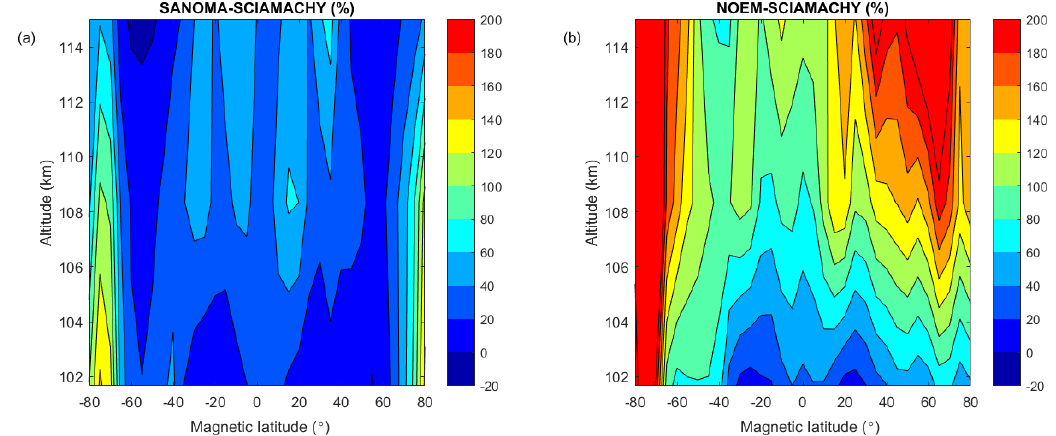
Figure 17. (a) Median difference between SANOMA and SCIAMACHY as a percentage of mean SCIAMACHY NO number density. (b) Median difference between NOEM and SCIAMACHY as a percentage of mean SCIAMACHY NO number density.